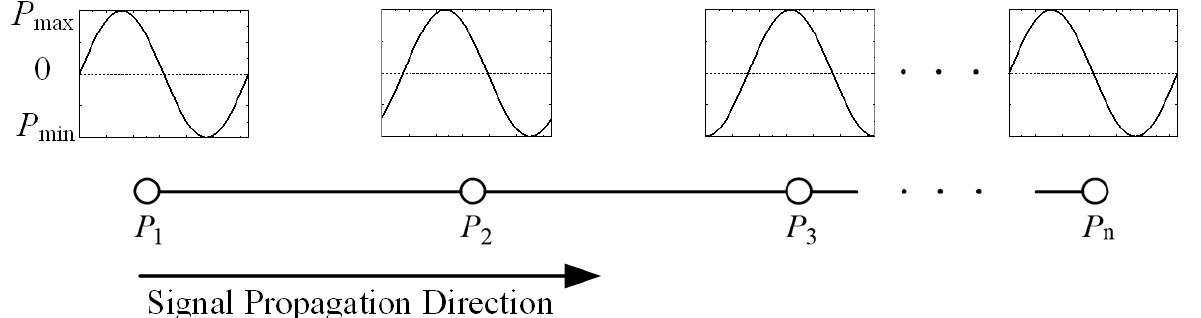
Figure 2. Schematic map of signal propagation.